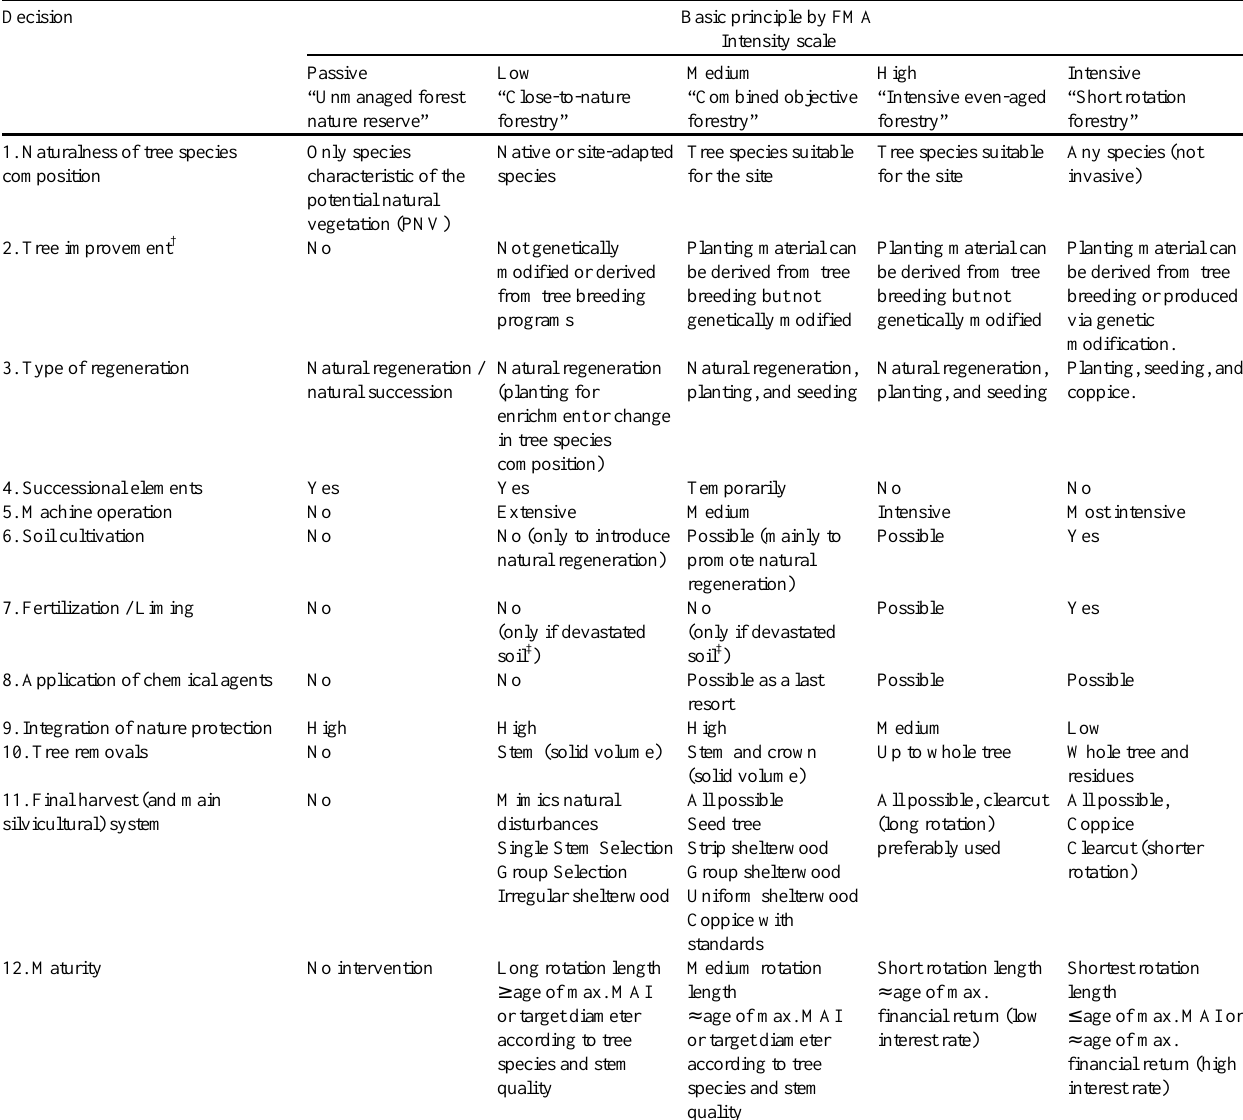
Table 2. A list of the 12 major decisions and the basic principles used to distinguish among five forest management approaches (FMAs) as well as the main silvicultural systems associated with each